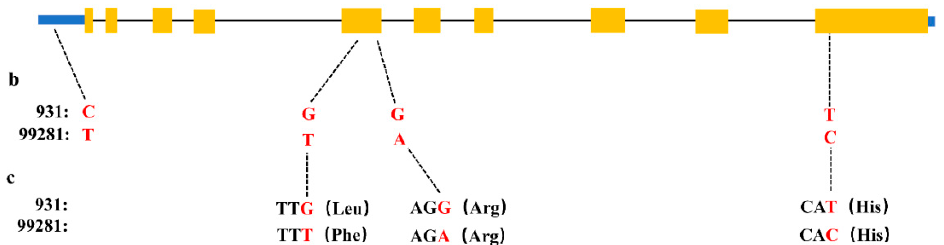
Figure 7. Nucleic acid and amino acid changes of Csa1G004990 . ( a ) Gene structure of Csa1G004990 . ( b ) One single-nucleotide substitutions (C/T) in the 5 ′ -untranslated region. Two single-nucleotide substitution (G/T, G/A) in 5 th exon and one single-nucleotide substitutions (T/C) in 10th exon. ( c ) Among the three single-nucleotide substitution, one caused amino acid substitution (Leu/Phe). The left blue box indicates the 5 ′ -untranslated region, the orange box indicates coding regions, the black line indicates an intron, and the right blue box indicates the 3 ′ -untranslated region.